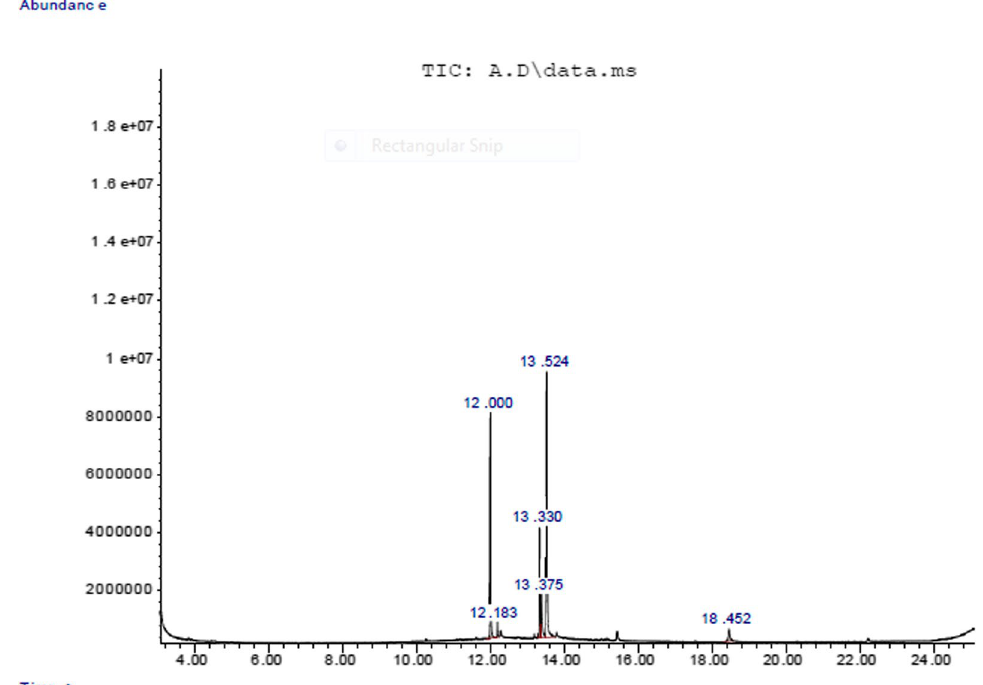
Fig. 7 GC–MS Spectra of Methanol extract of Costus afer leaf